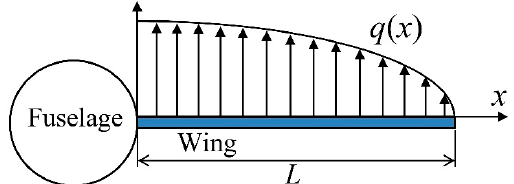
Figure 6. Distribution of aerodynamic loads over a single wing.